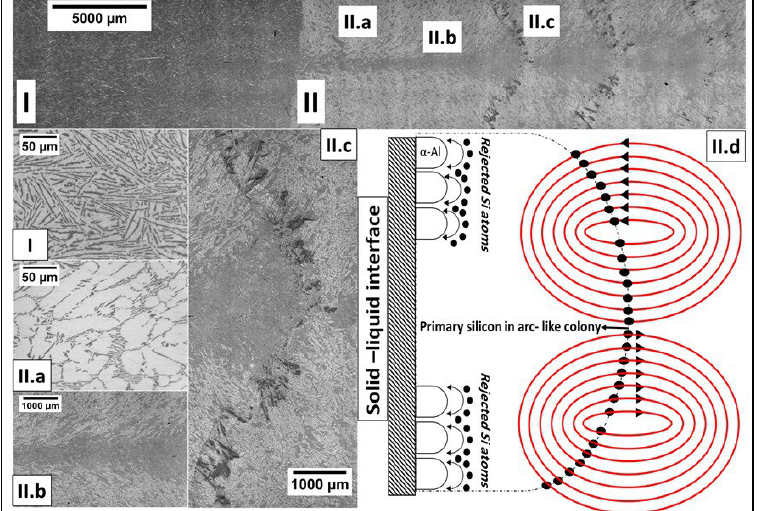
Figure 3. Micrographs of sample AlSi100 showing the microstructure of Al–12.6-wt%-Si alloy ( I ) macro- and micro-structures without magnetic stirring; ( II ) macro-structure under 100 mT magnetic stirring; ( II.a ) microstructure of primary Al at the edges of the sample; ( II.b ) Christmas-tree-like (CTL) segregation pattern; ( II.c ) primary Si arc-like segregation; ( II.d ) formation mechanism of the primary arc-like segregation pattern.